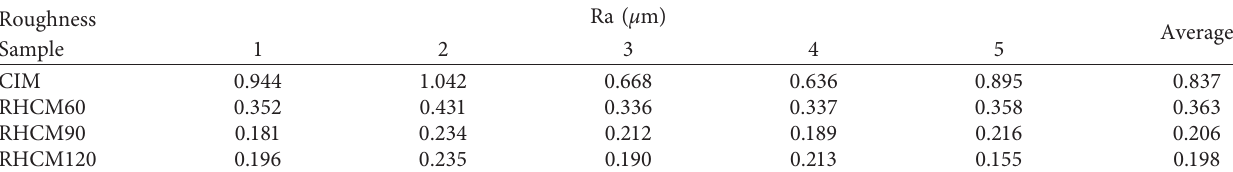
Table 2: Surface roughness of test